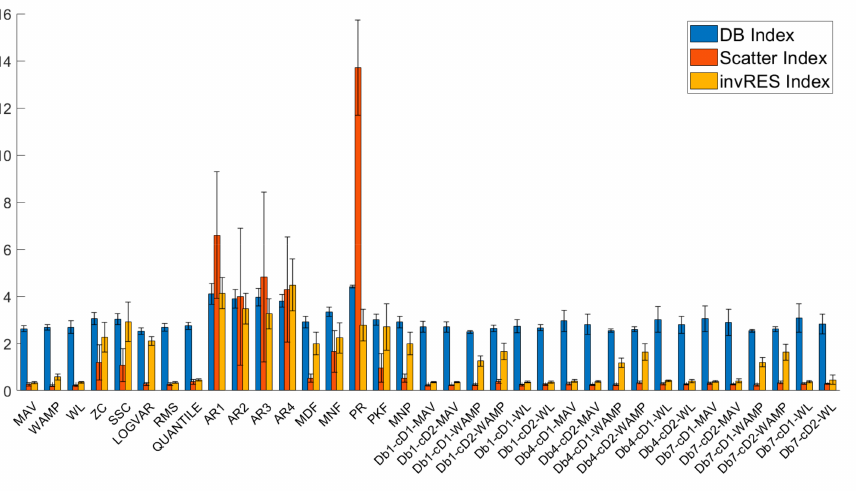
Figure 7. The separability index of features.